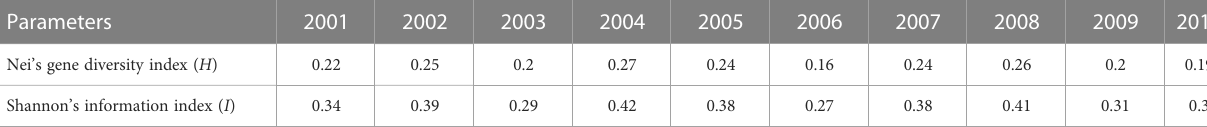
TABLE 2 Virulence diversity parameters of 10 Puccinia triticina